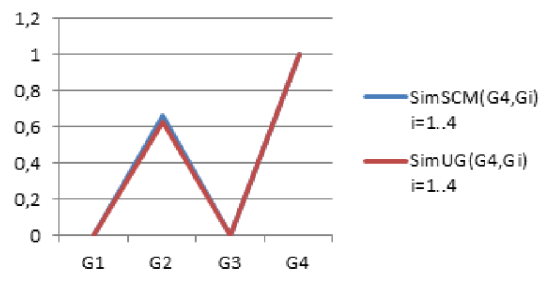
Fig. 3. Comparison of Sim UG and Sim CMS